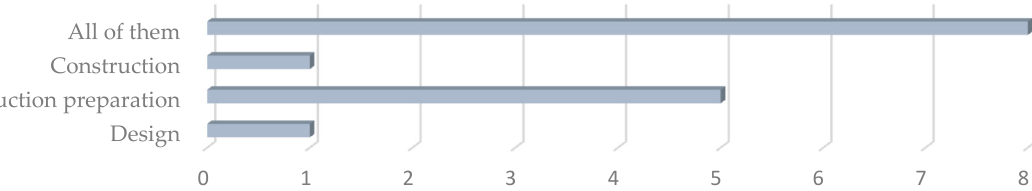
Figure 4. Responses to the question: “What stage do you think is the most appropriate for applying detection so that it directly increases the level of health and safety on the construction site?”